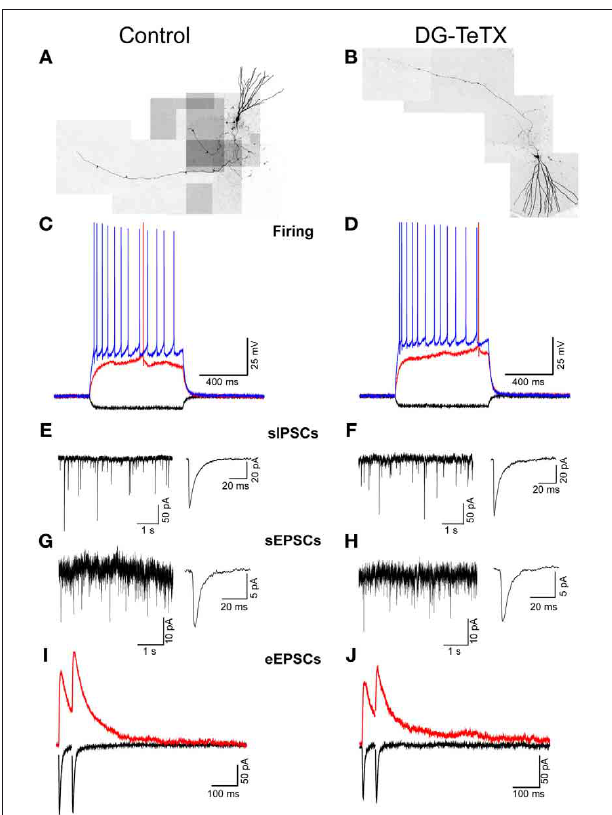
FIGURE 4 | Prolonged blockade of the synaptic output from old GCs does not alter their electrophysiological characteristics. (A,B) Composite images of representative old GCs recorded in slices from control (A) and activated DG-TeTX (B) mice. (C,D) Traces from representative recordings obtained in old GCs of control (C) and activated DG-TeTX mice (D) showing membrane responses to hyperpolarizing ( − 50pA; black traces), just threshold level depolarizing (red traces) and twice threshold level depolarizing (blue traces) current pulses. (E–H) Representative gap-free traces of pharmacologically isolated spontaneous GABA A receptor- and AMPA receptor-mediated IPSCs (E,F) and EPSCs (G,H) with ensemble averages (right traces) obtained in old GCs of control (E,G) and DG-TeTX (F,H) mice. (I,J) Paired pulse (50ms inter-stimulus interval) perforant path-evoked EPSCs at a holding potential of − 70mV (black traces, to monitor the AMPAR-mediated component) and at a holding potential of + 40mV (red traces, to reveal the NMDAR-mediated component) in representative recordings from old GCs in control (I) and DG-TeTX (J) mice.